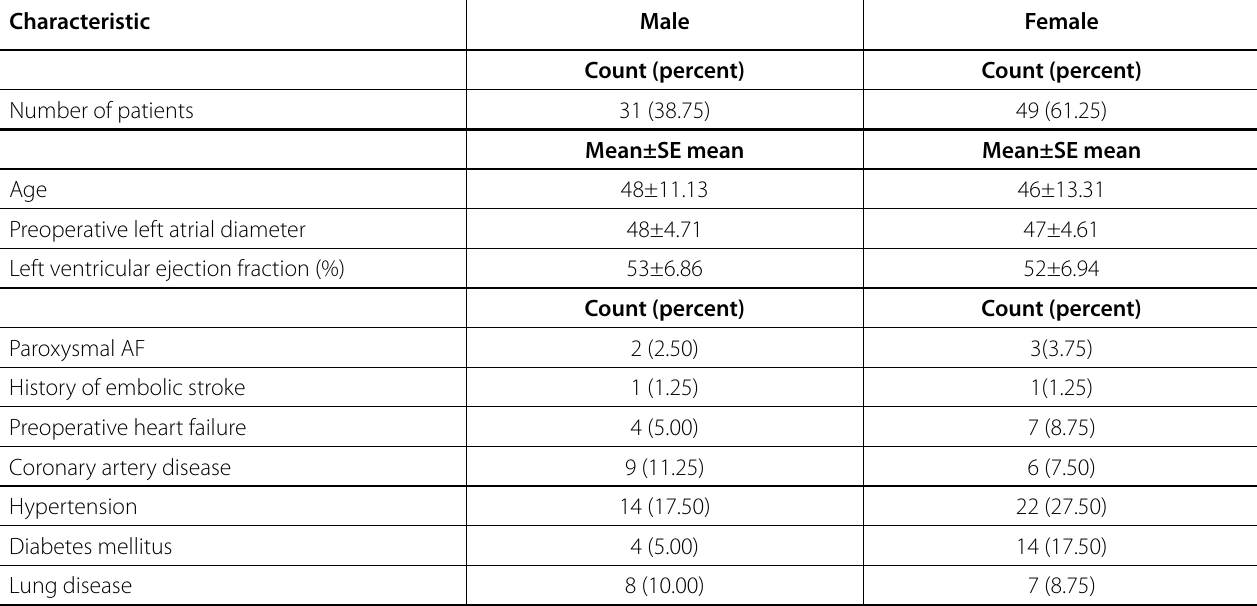
Table 1 . Descriptive statistics for the patients’ characteristics.